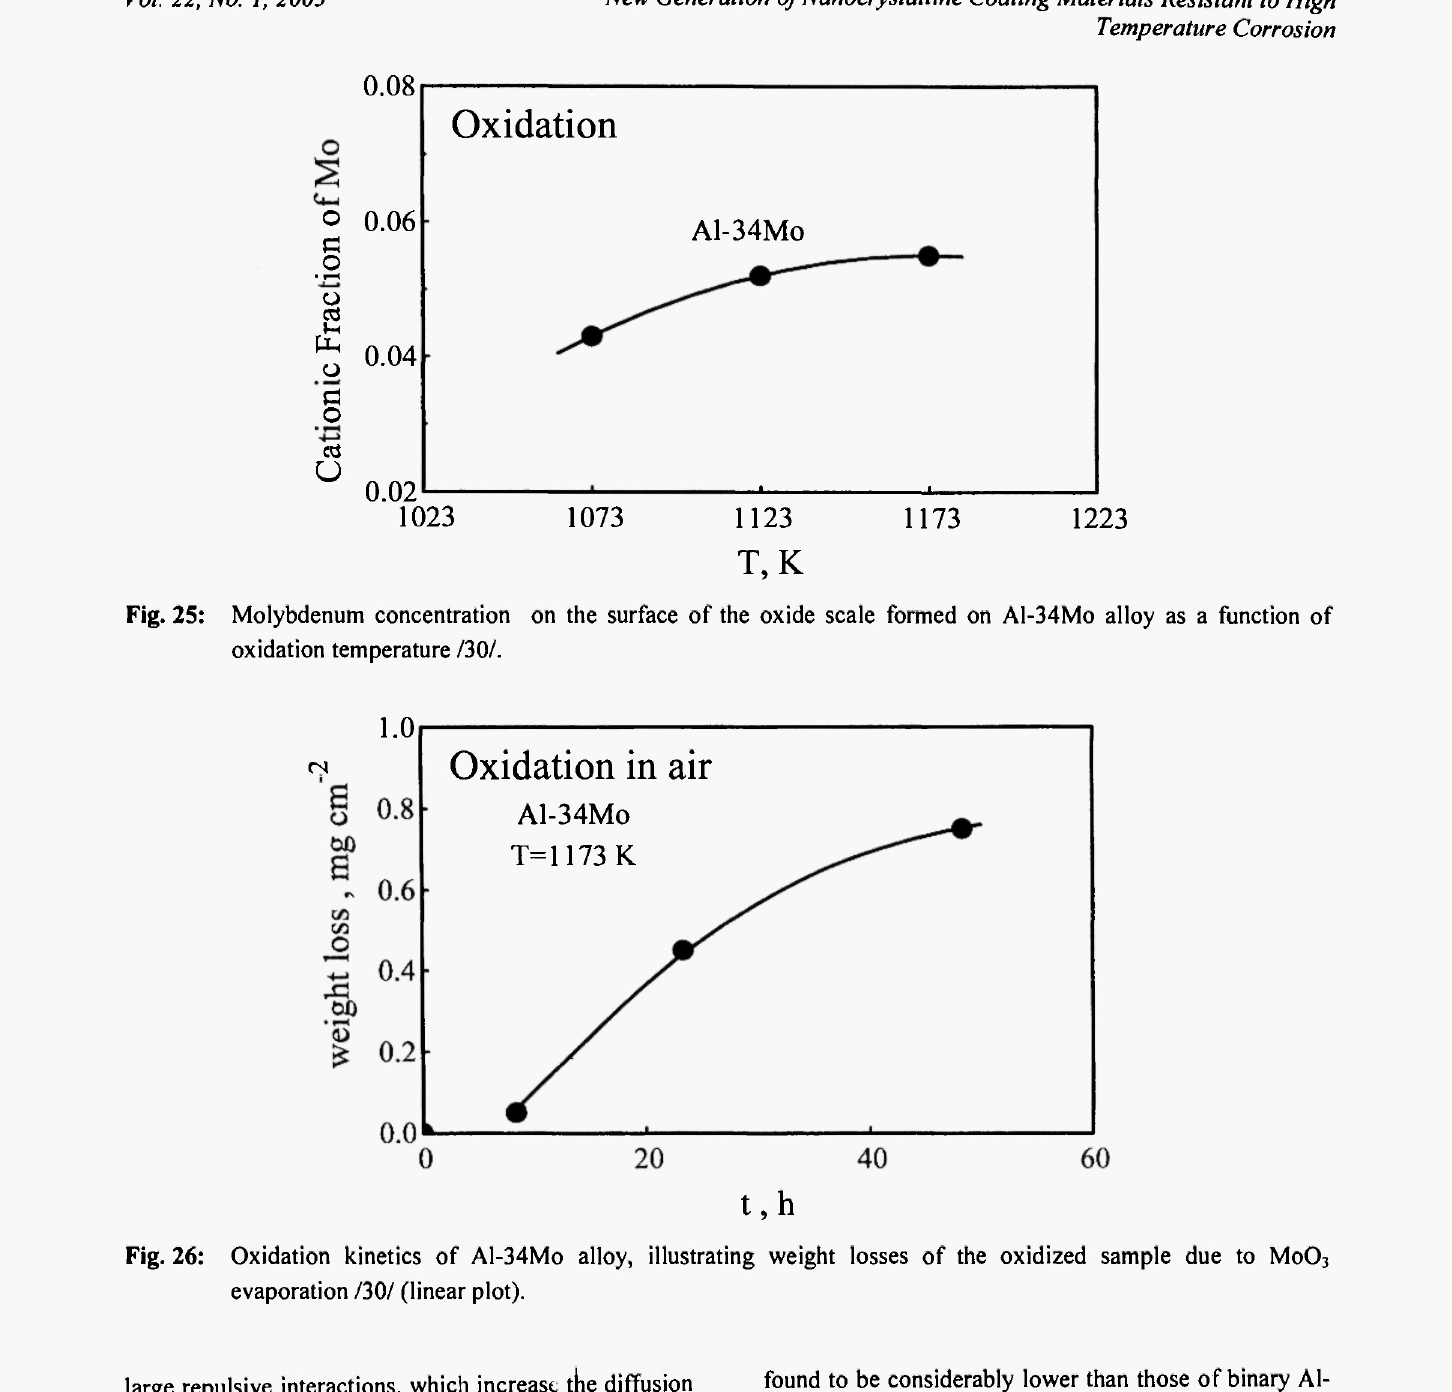
Fig. 26: Oxidation kinetics of Al-34Mo alloy, illustrating weight losses of the oxidized sample due to M0O3 evaporation 730/ (linear